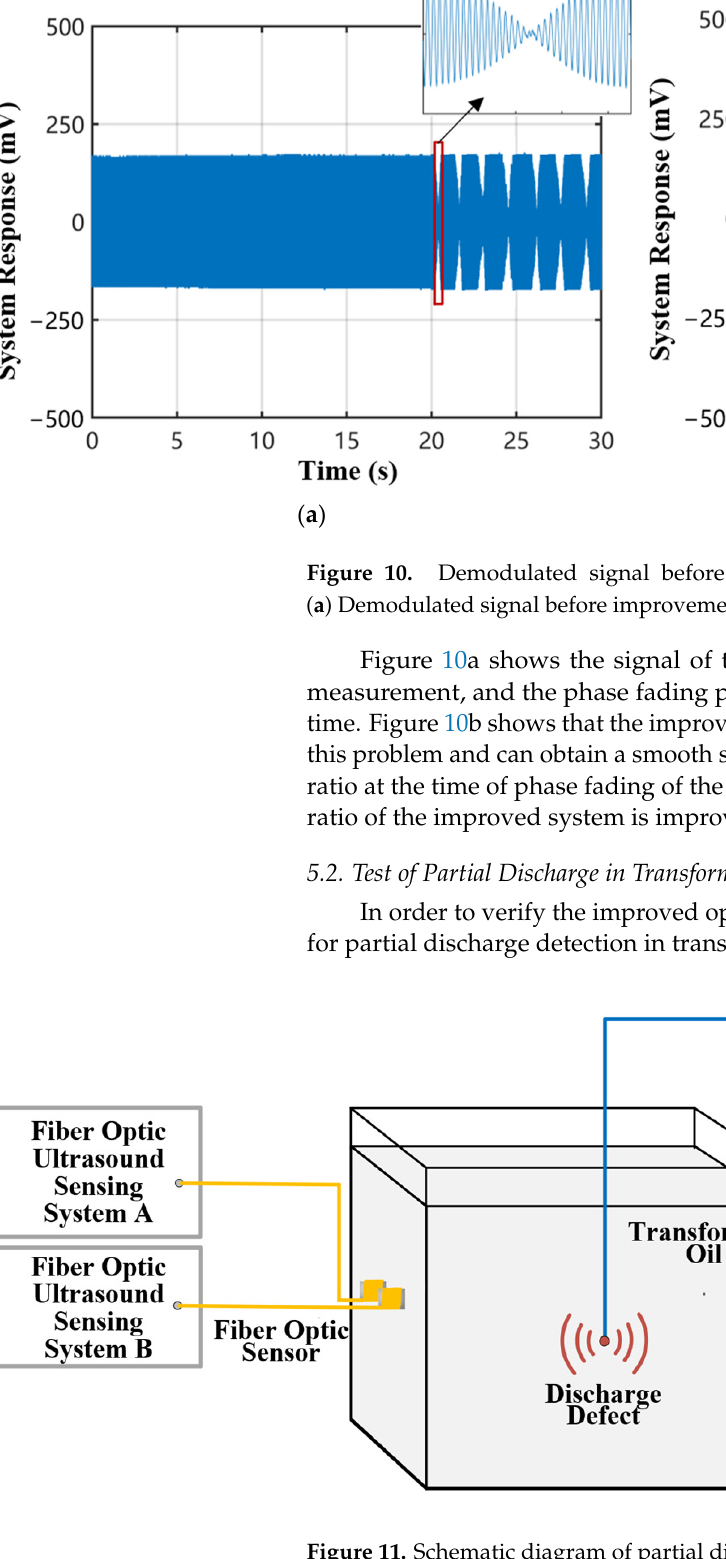
Figure 11. Schematic diagram of partial discharge detection in oil based on optical fiber ultrasonic sensing system.